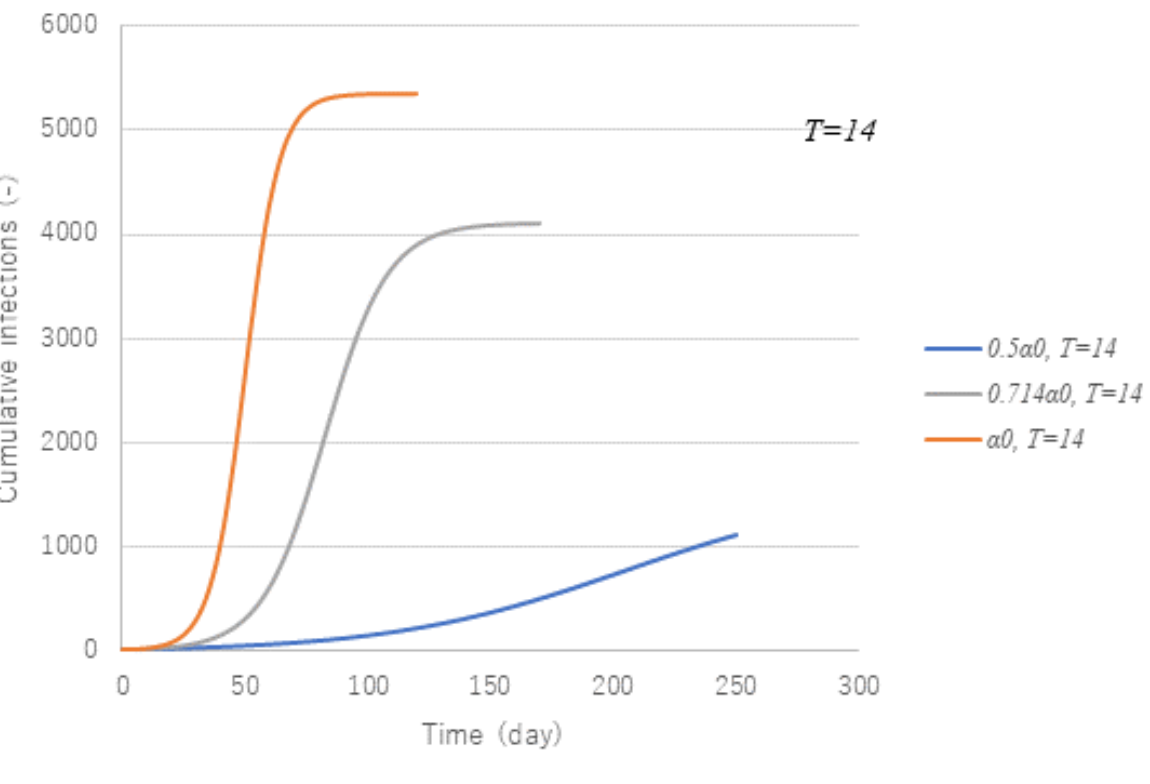
Figure 11. Effect of transmission rate α on cumulative infections. With a reduced transmission rate α , the final size x( ∞ ) was observed to be smaller and took longer to be attained.